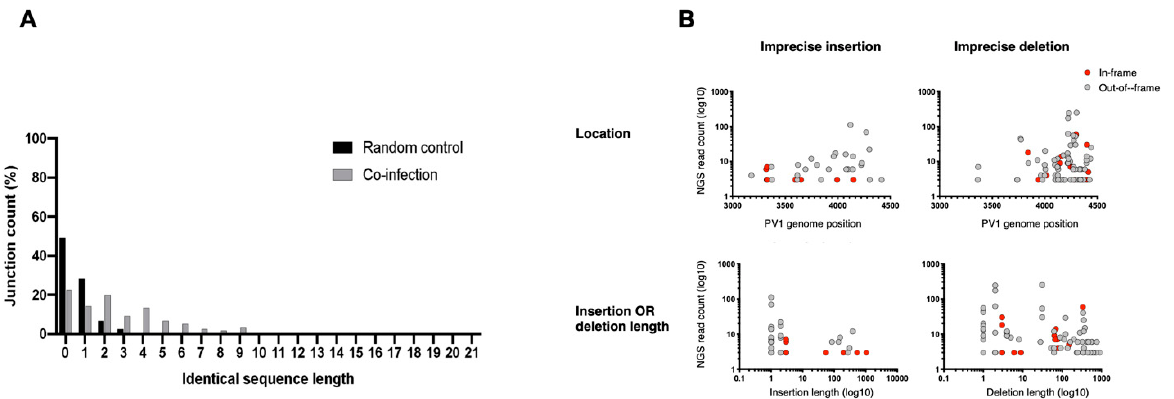
Figure 5. The influence of identical sequence length and reading frame on imprecise recombination. ( A ) The imprecise recombinants were counted at each identical length ( x -axis) and the percentage proportion related to the total imprecise junctions was calculated ( y -axis). The flattened data of the imprecise recombinants generated from the coinfection experiments (grey) were plotted against a random control (black), where every possible imprecise junction was created and classified using a custom Perl script. ( B ) In the upper panel, the locations of the detected imprecise recombinants on the PV1 genome were plotted against the NGS read count. In the lower panel, the size of either the insertions or deletions of the detected recombinants were plotted against NGS read count. Each dot represents a unique recombinant.